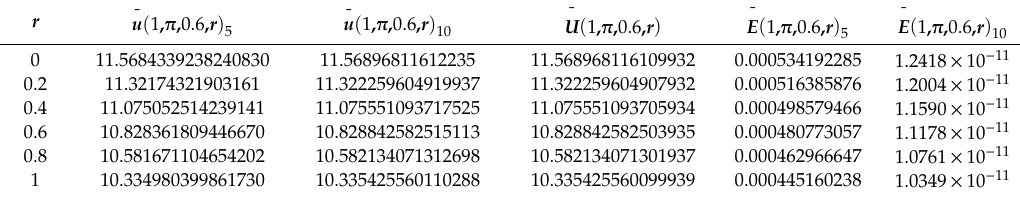
Table 10. Solution and accuracy of fifth and tenth order double parametric fuzzy HPM solutions for Equation (32) at t = π , x = 1 and b = 0.6 for all r ∈ [ 0,1 ] .